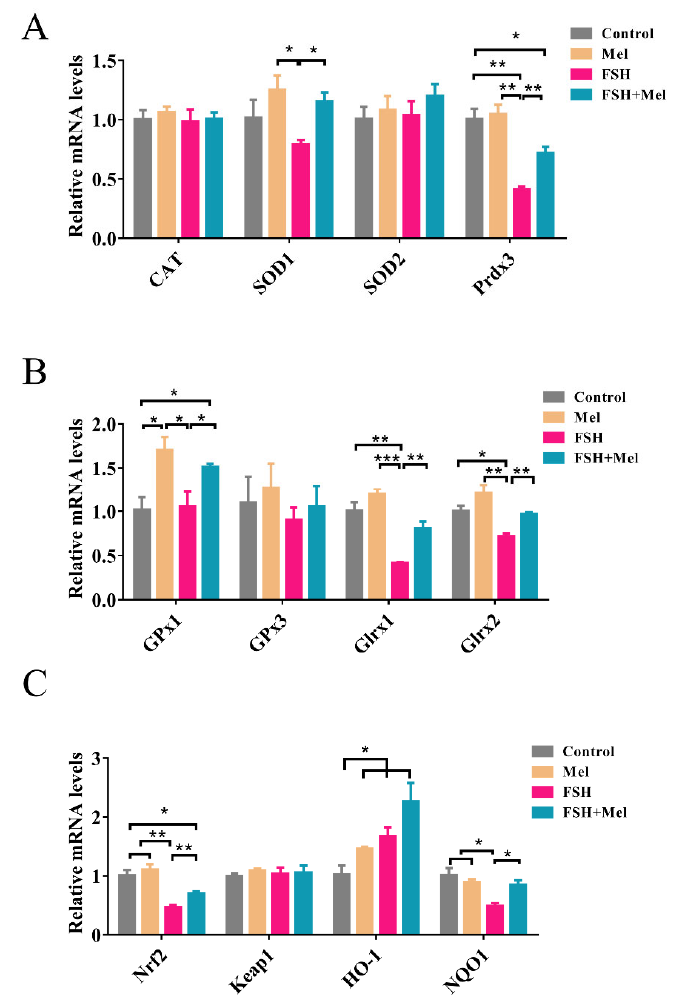
Figure 5. Effect of Mel and FSH on the expression of antioxidant enzymes in mRNA level. ( A ) The mRNA level expression of CAT (catalase), SOD1 , SOD2 and Prdx3 in ovary. ( B ) The mRNA level expression of Gpx1 , Gpx3 , Glrx1 and Glrx2 in ovary. ( C ) The mRNA level expression of Nrf2 , Keap1 , HO-1 and NQO1 in ovary. Horizontal bars denote treatments differing p < 0.05 *, p < 0.01 **, p < 0.001